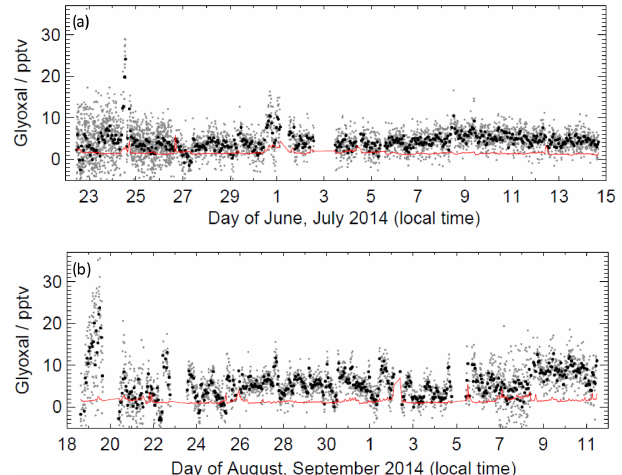
Figure 5. Time series of glyoxal data during (a) campaign 1 and (b) campaign 2. Black data points show 1h mean; grey data points show the mean for a single measurement cycle (approximately 7min); red line shows limit of